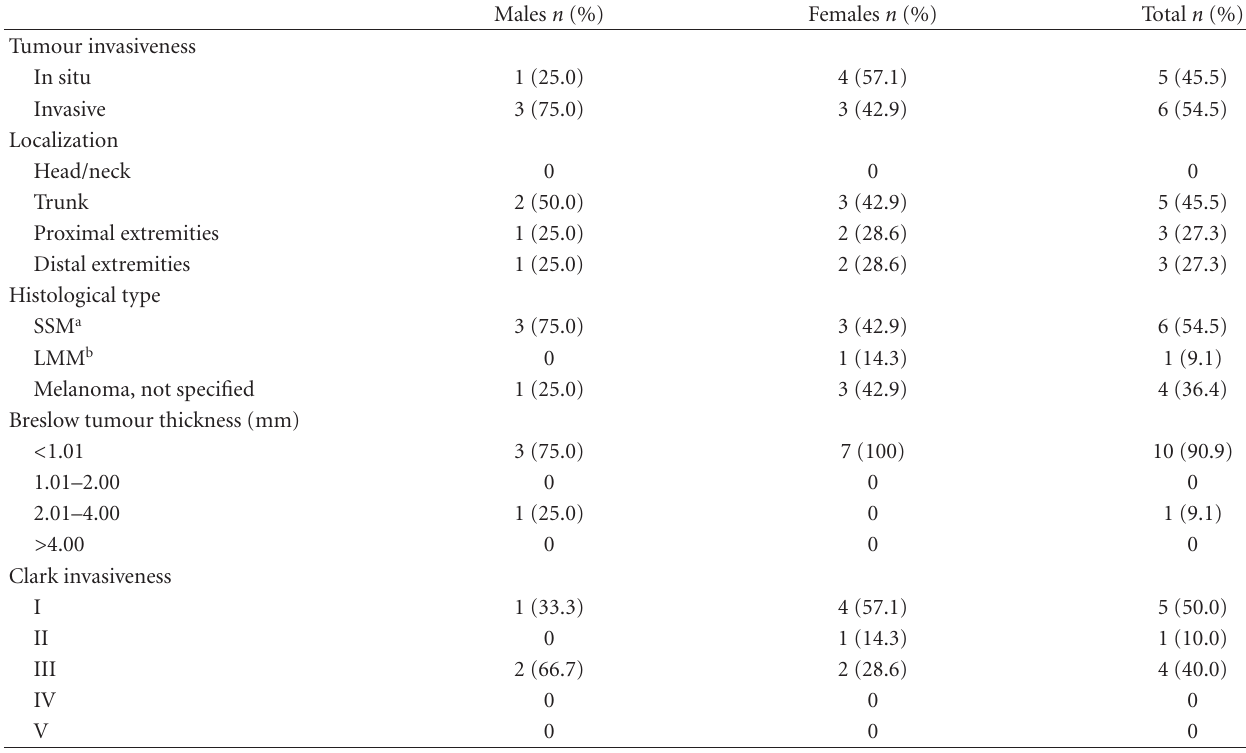
Table 2: Descriptive statistics for the second cutaneous melanoma (CM 2).